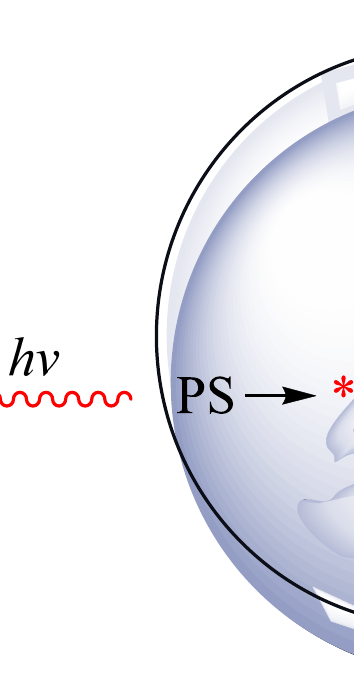
Figure 1. Singlet oxygen generation in vitro.